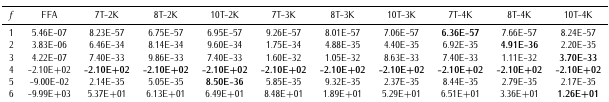
Table 7. Results: 40 fireflies and Crossover with Simulated Annealing with the K best